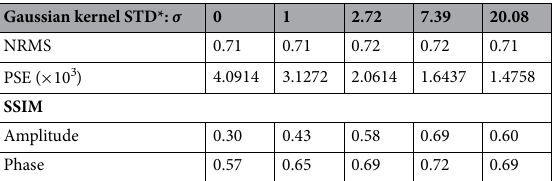
Table 1. Comparison of the SSIM and PSE indices of the reconstructed images in Fig. 5b,c respect to the scattering power of each simulated hologram. * STD standard deviation.